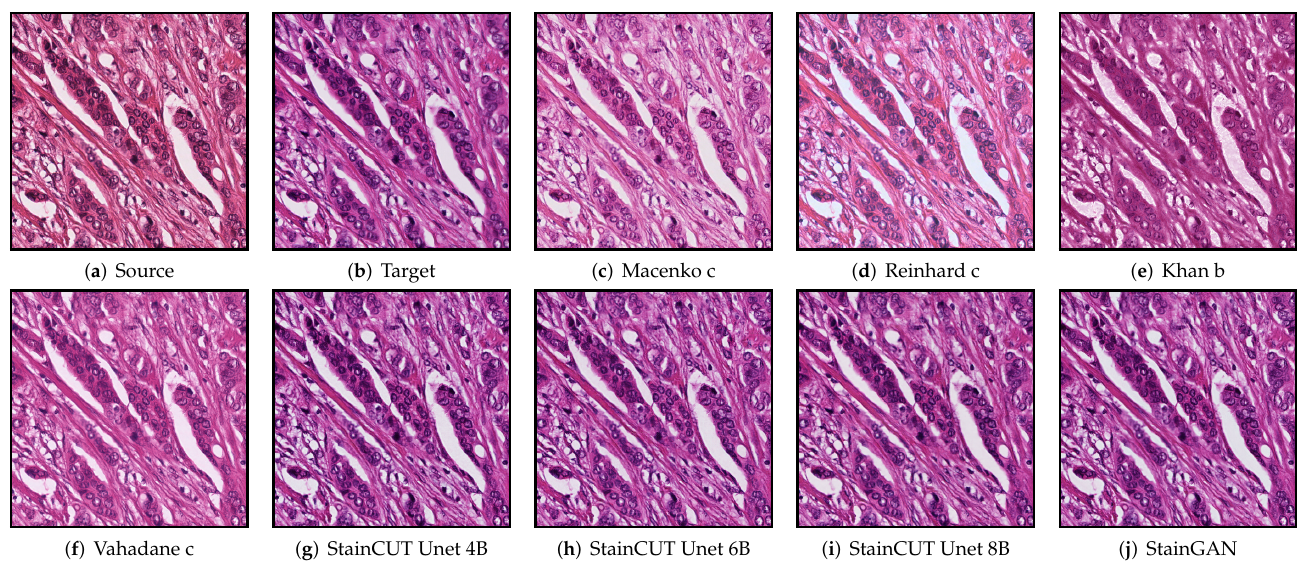
Figure 5. Stain normalization of source patch (a) to target patch (b) using different methods. For the classical methods we show only the result the corresponds to the reference frame with the best SSIM score.